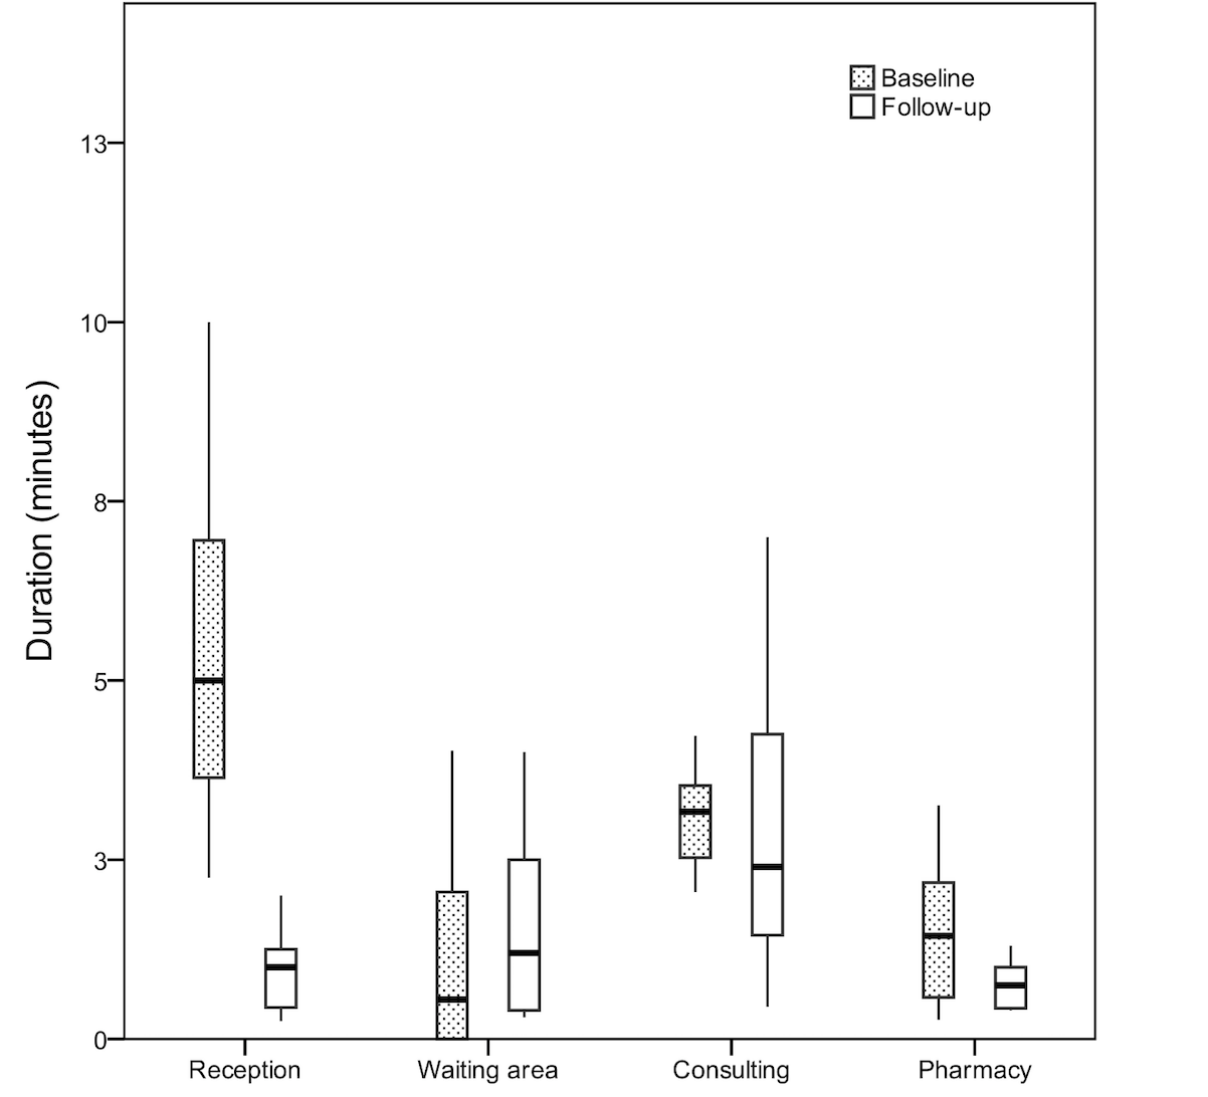
Figure 3. The time spent performing tasks at 1 electronic health record–based primary health care center after 1